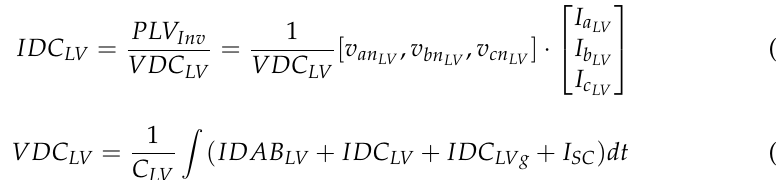
Figure 9. Block diagram of the ST’s Low Voltage inverter. The active power in the LV inverter is defined by Equation (11), where IDC LV is the DC current exchanged with the LV DC bus, PLV Inv is the active power in the LV inverter, VDC LV is the LV DC bus voltage, v an , v bn and v cn are the phase-neutral LV AC voltages (in LV LV LV phases a , b and c ) in the LV inverter ( VAC LV ), and i a , i b and i c are the AC currents LV LV LV in the LV inverter’s phases a , b and c ( IAC LV ). VDC LV is defined by Equation (12), where C LV is the capacitance of the LV DC bus, and IDAB LV , IDC LVg and I SC are the DC currents and the supercapacitor bank, respectively.